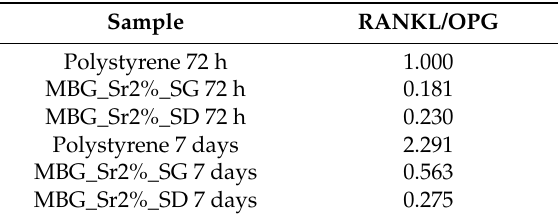
Table 5. RANKL/OPG ratio at 72 h and 7 days, for MBG_Sr2%_SG, MBG_Sr2%_SD and polystyrene. A significant down regulation of RANKL and an overexpression of OPG, results in a RANKL/OPG ratio in favour of bone remodelling at both time